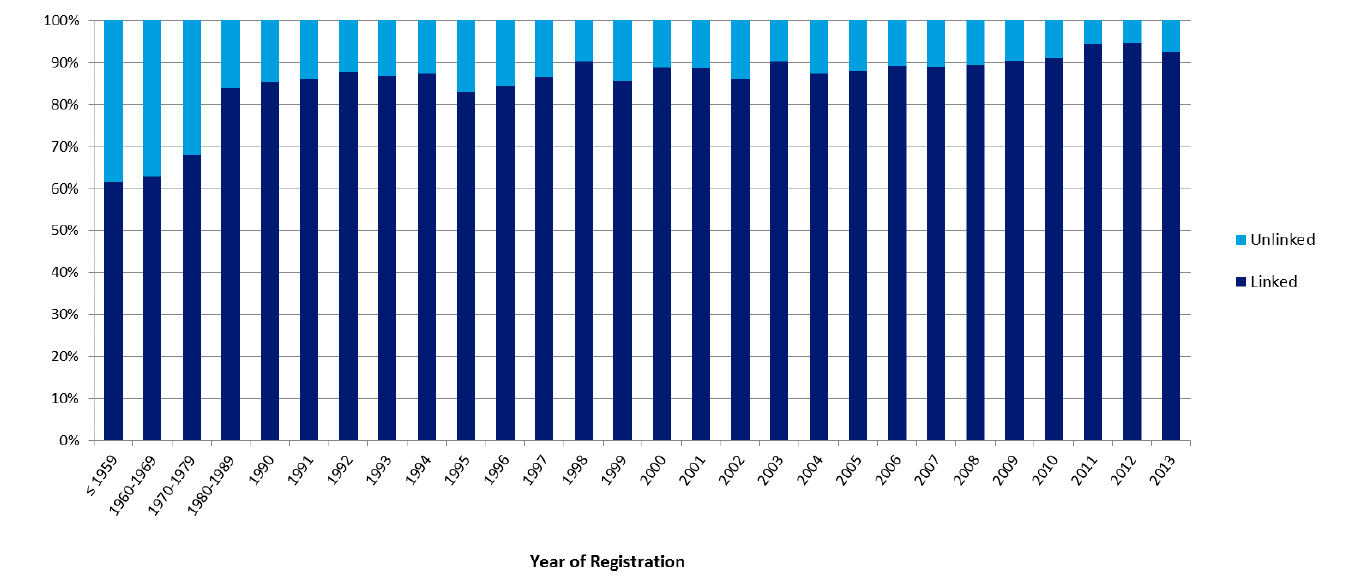
Figure 2: Proportion of those with an Ontario province code linked and unlinked, by year of registration in the